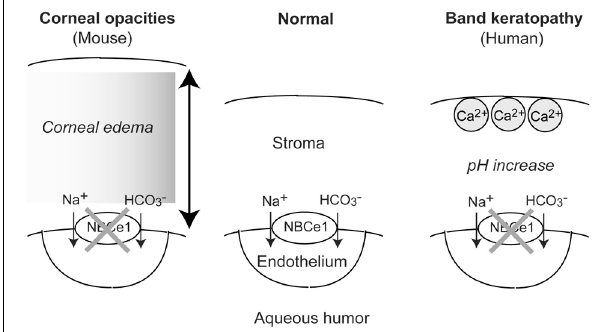
FIGURE 2 | Roles of NBCe1 in the corneal endothelium. In mouse, NBCe1 inactivation may induce corneal edema, resulting in corneal opacities. In human, NBCe1 inactivation may increase local pH, resulting in band